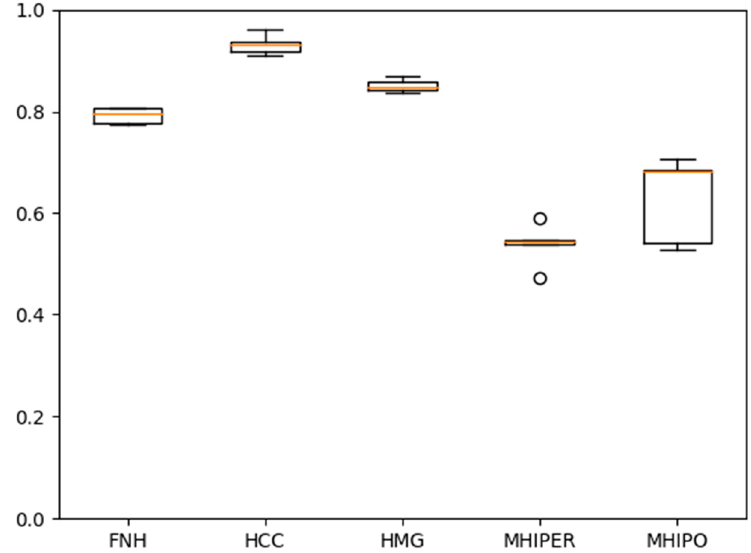
Figure 10. Experiment # 4 from a total of five-accuracies. The Boxplot representation extends from the lower to upper quartile values of the data, with a line at the median. The hard vote case.